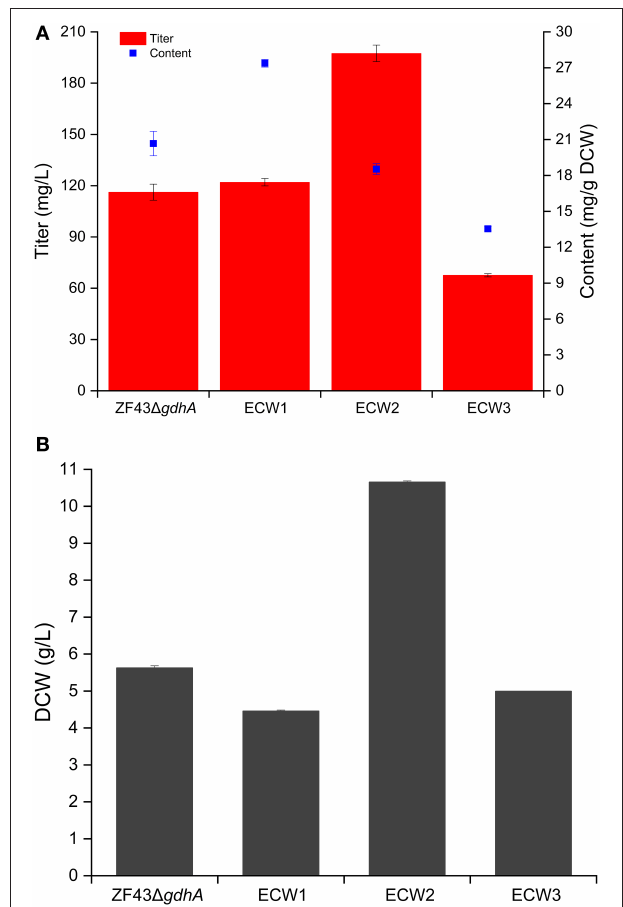
FIGURE 2 | Effects of zwf deletion and phosphotransferase system inactivation on β -carotene production (A) and biomass generation (B) in Escherichia coli strain ZF43 1 gdhA . The results represent the means from four independent experiments, and the error bars represent standard